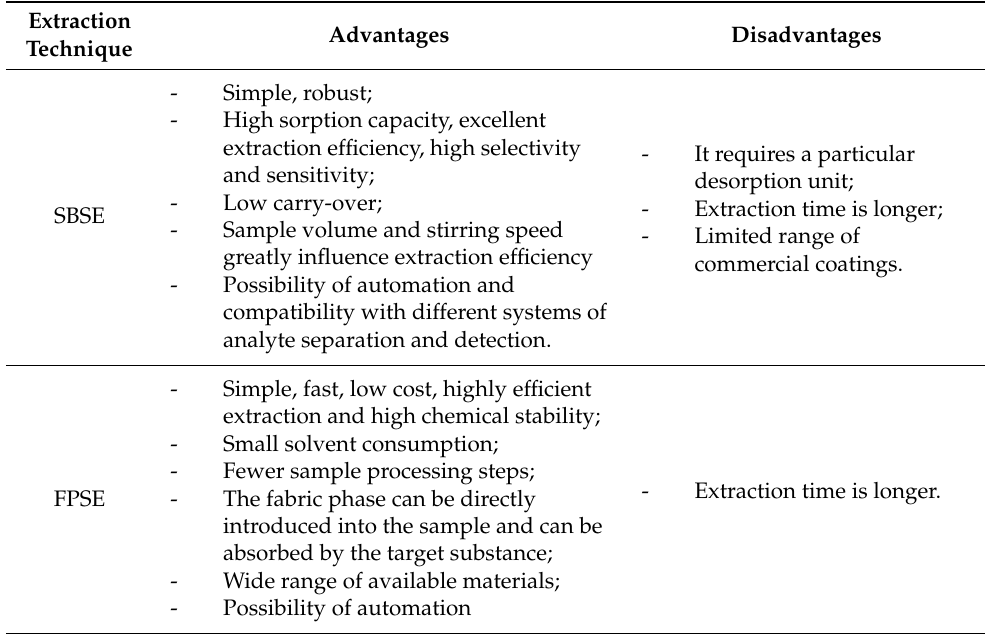
Table 11. Advantages and disadvantages of the SBSE and FPSE